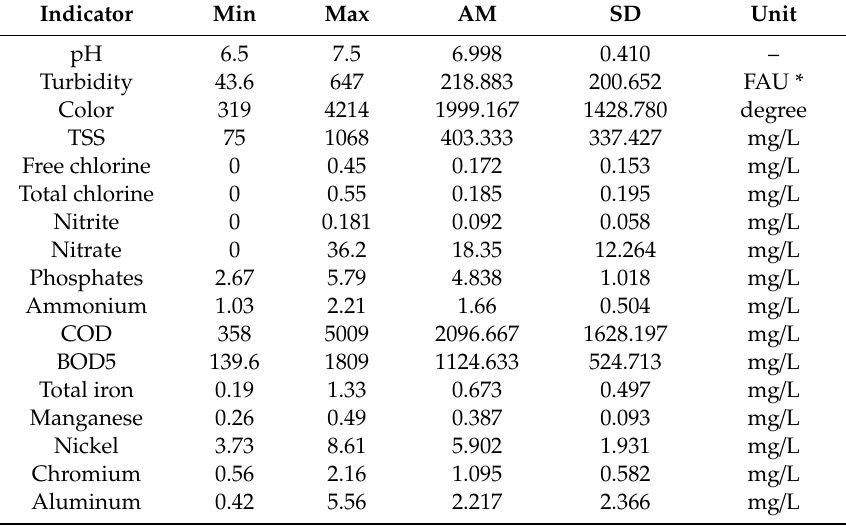
Table 1. General characteristics of raw wastewater (number of samples =